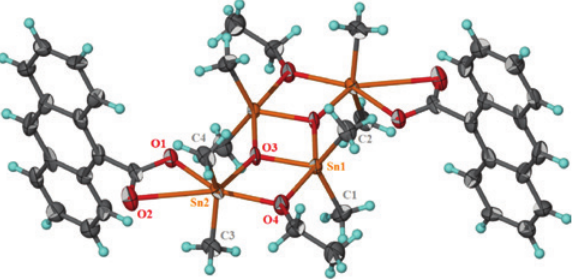
Figure 2: A perspective view of the interaction between the oxygen atom of the carboxylate ligand with the tin atom of a neighboring molecule to form a chain running along the b axis.